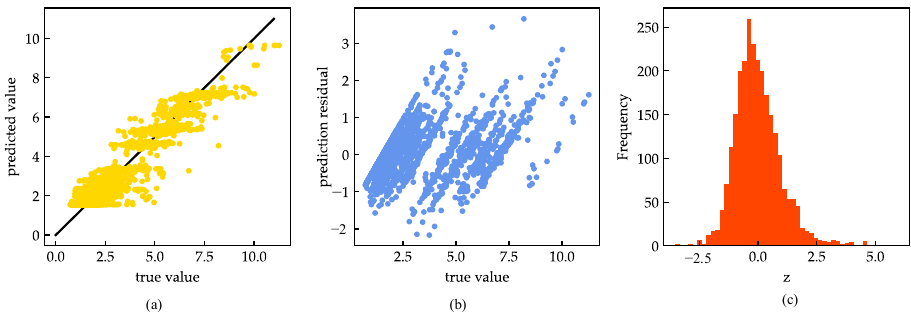
Figure 8. The prediction performance of LightGBM: ( a ) The scatter plot between predicted value and true value; ( b ) The scatter plot between prediction residual and true value; ( c ) The histogram of z in the model.